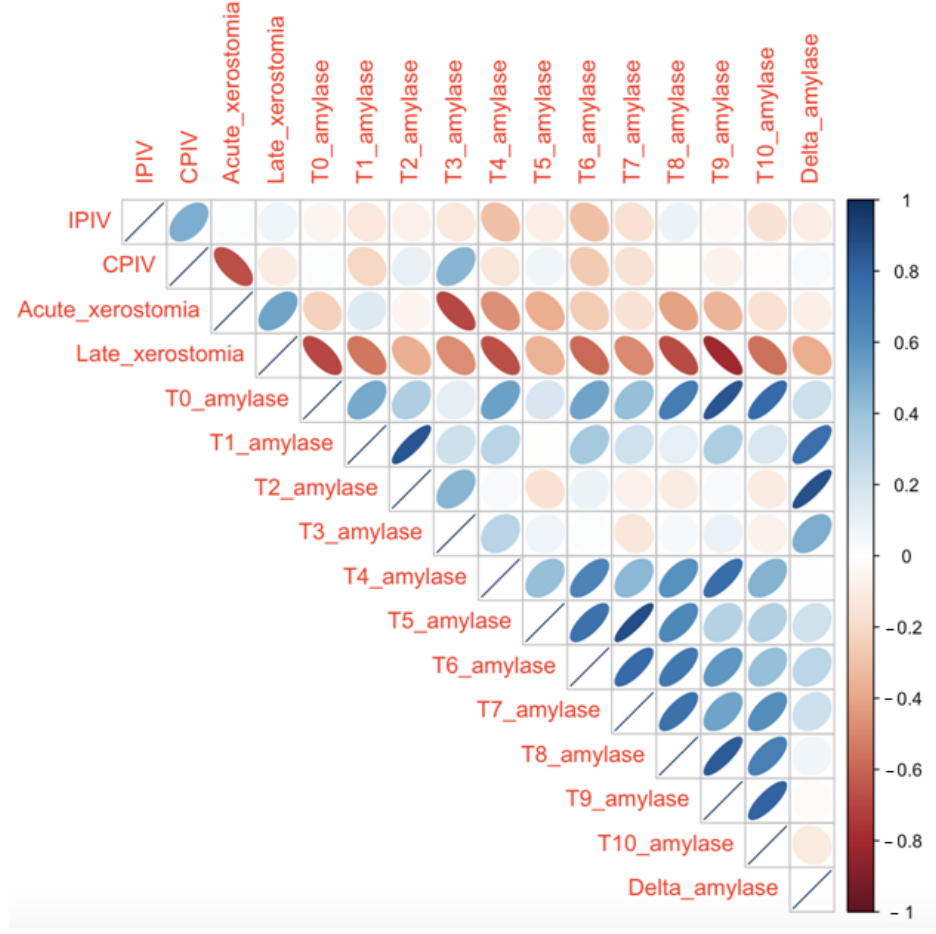
Figure 3. Correlation matrix between different clinical variables. Each ellipse in the table represents a correlation between the two variables. The diagonal indicates that each variable perfectly correlates with itself. Time points: at baseline (t0); during the first week of treatment, before each fraction of CRT (t1, day one; t2, day two; t3, day three; t4, day four; t5, day five); and then at intervals of one week after the start of CRT (t6, week two; t7, week three; t8, week four; t9, week five; t10, week six). Delta amylase was defined as the change between baseline and higher serum amylase value.